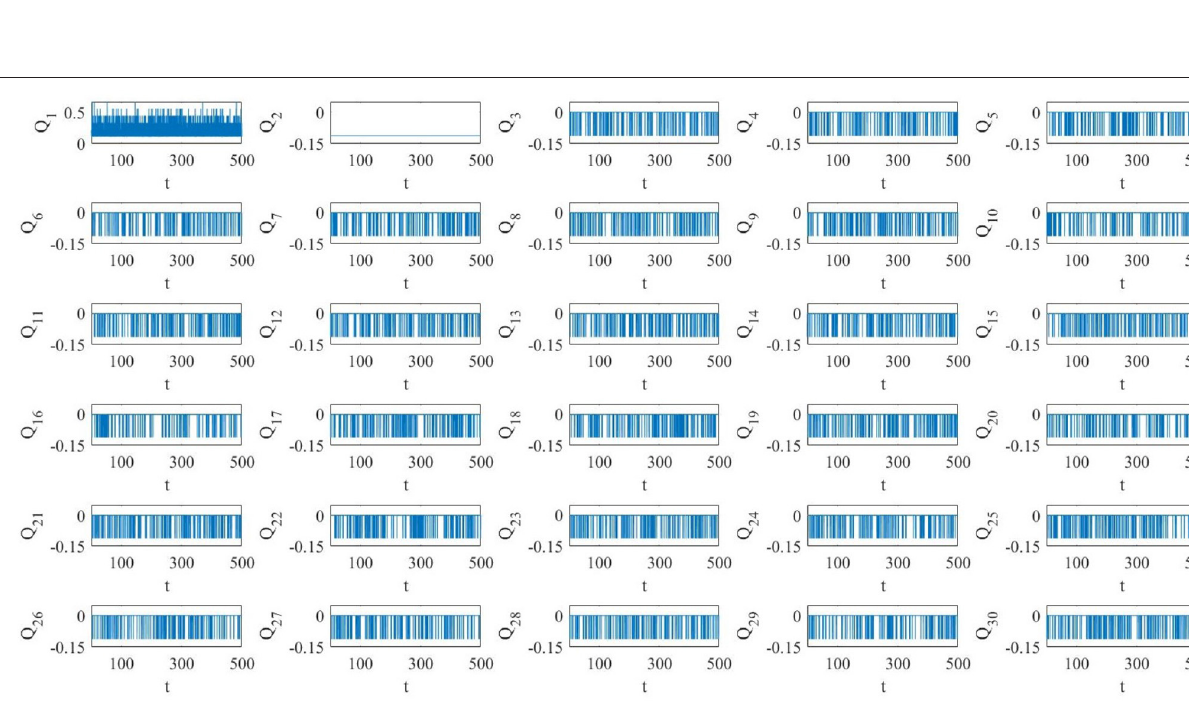
Frontiers in Neuroscience |